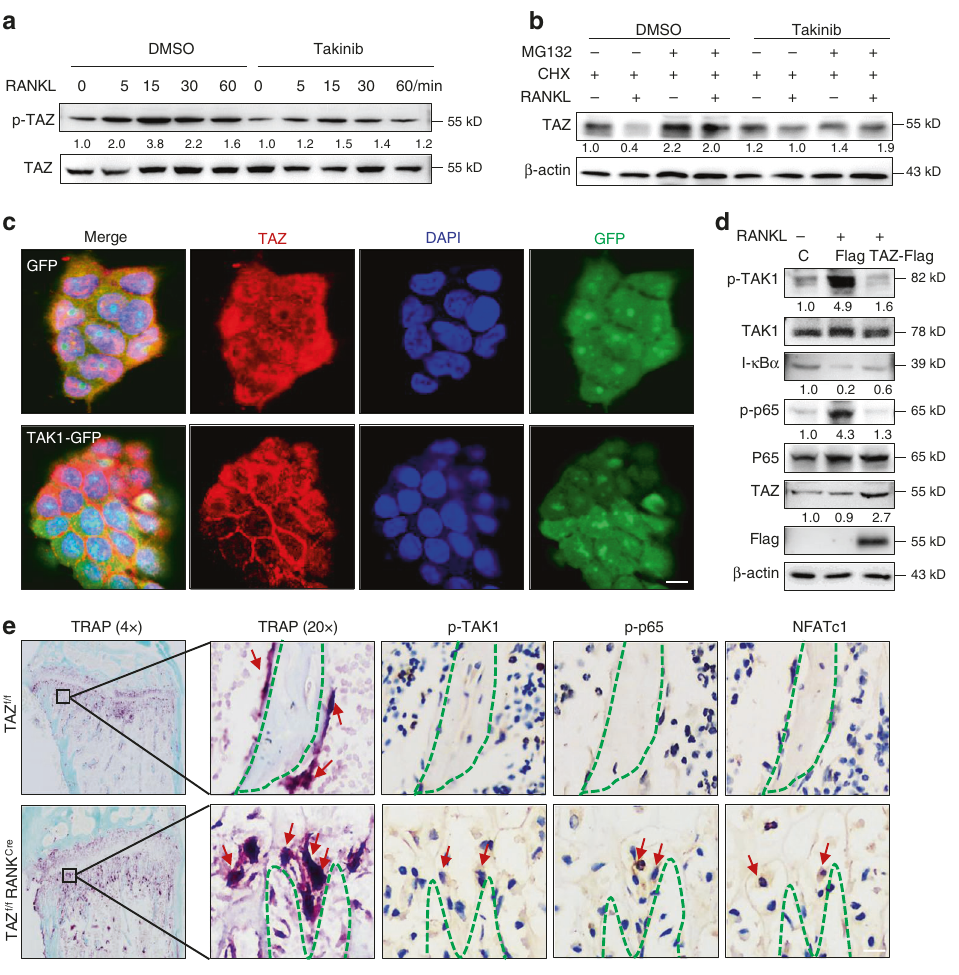
Fig. 6 Reciprocal suppression between TAZ and NF- κ B pathway components regulates osteoclastogenesis. a Western blot analysis evaluating the effect of takinib on TAZ phosphorylation during RANKL stimulation in BMMs. b Western blot analysis evaluating the effect of takinib on TAZ degradation with CHX pretreatment for 2 h followed by treatment with RANKL for 6 h along with MG132 in BMMs. c TAZ immuno fl uorescence staining of HEK 293T cells transfected with the GFP empty vector or TAK1-GFP overexpression plasmid. Scale bar denotes 10 μ m. d Western blot analysis evaluating the effect of TAZ overexpression on p-TAK1, I- κ B α , and p-p65 levels upon RANKL stimulation for 15 min in BMMs. e TRAP staining and p-TAK1, p-p65, and NFATc1 immuno fl uorescence staining of cancellous bone from the proximal tibia of TAZ f/f and TAZ f/f RANK cre mice. Scale bar denotes 20 μ m. BMMs, bone marrow-derived macrophages; CHX,